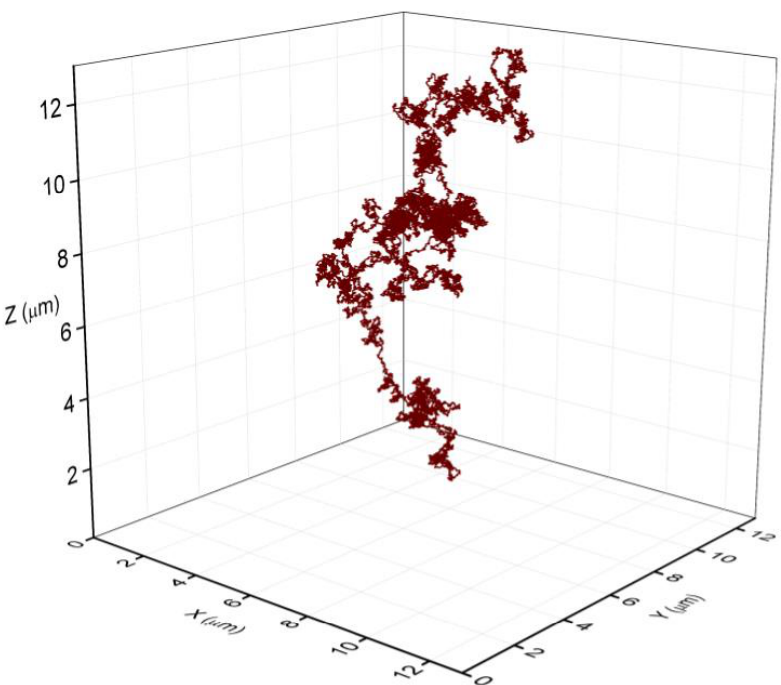
Figure 6. The volume space of a single eDNA released from a dying bacterium. The representative structure was obtained with a string of beads model. The scale unit on all axis is 2 μ m, the average Rg of eDNA was 8 μ m at persistence lenght of 50 nm [31,35] . The model eDNA was composed of 700,000 beads of 2 nm in diameter corresponding to the thickness of B-DNA and representing 4.2 Mbp of B. subtilis genome.